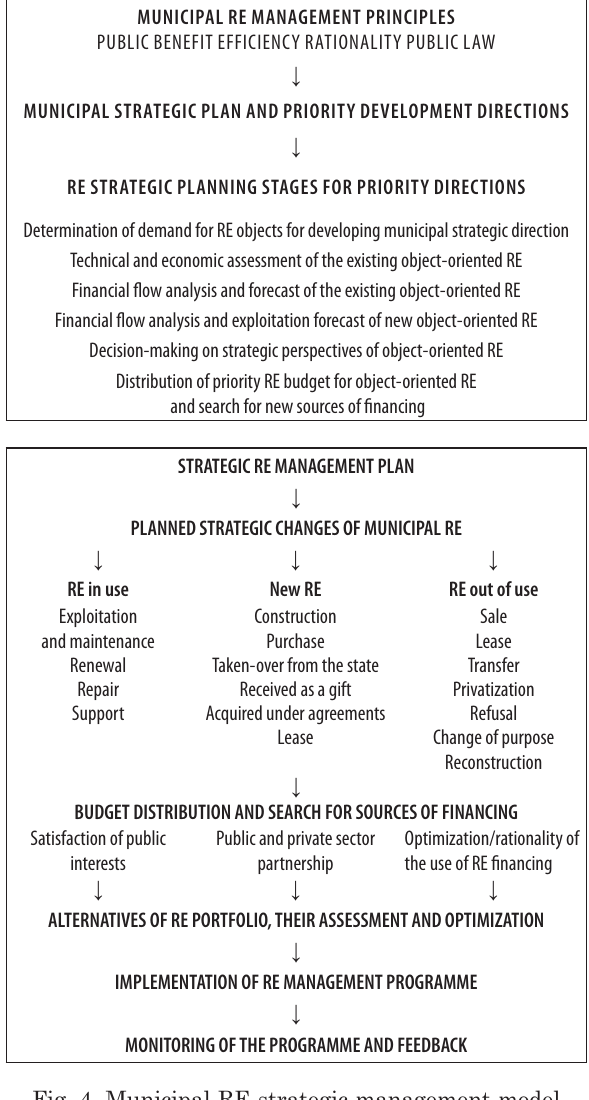
Fig. 4. Municipal RE strategic management